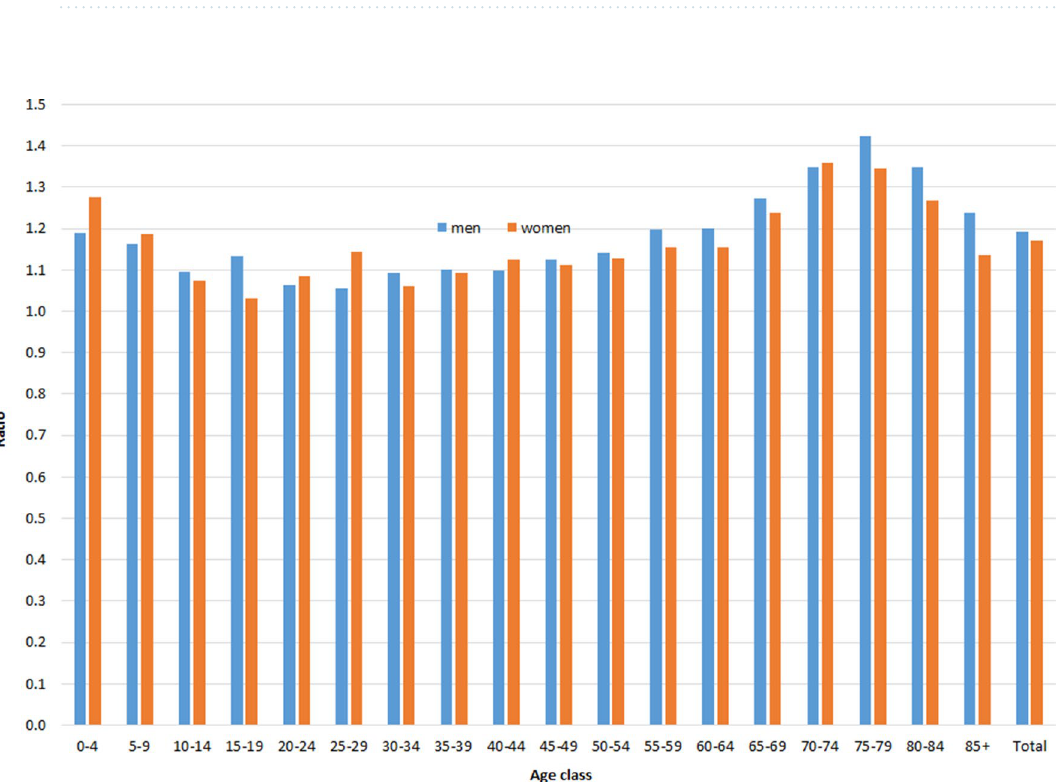
Figure 3. Ratio between age-specific mortality rates of immigrants resident in Italy, calculated including and excluding deaths occurred in the country of origin, by sex. Istat,